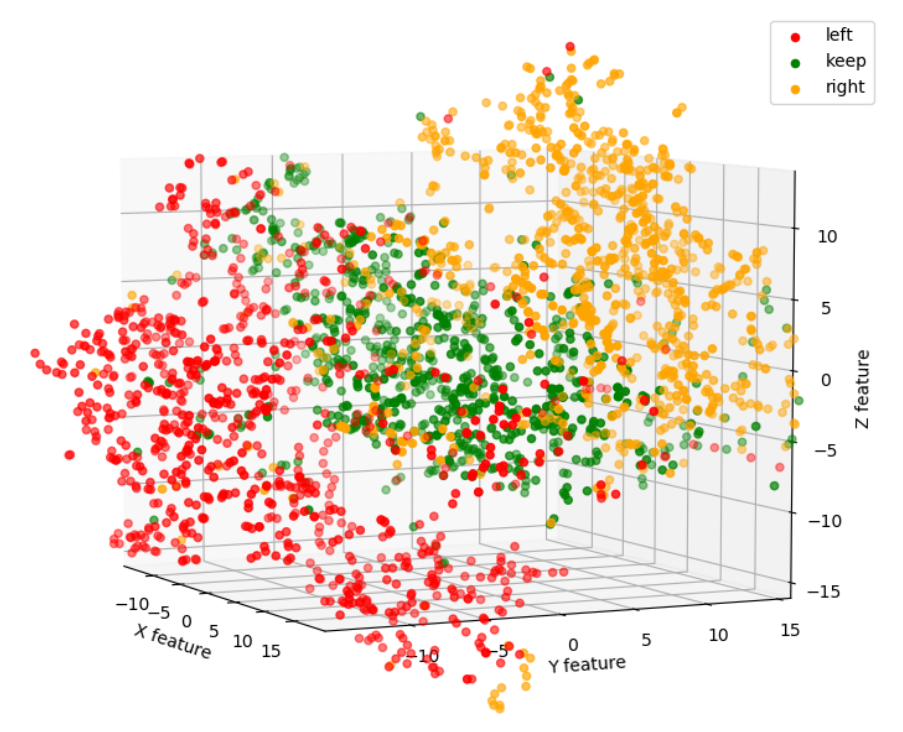
Figure 6. The 10-dimensional latent space visualized by t-SNE embedding in three dimensions. Every dot represents a trajectory, and the colors encode the maneuver